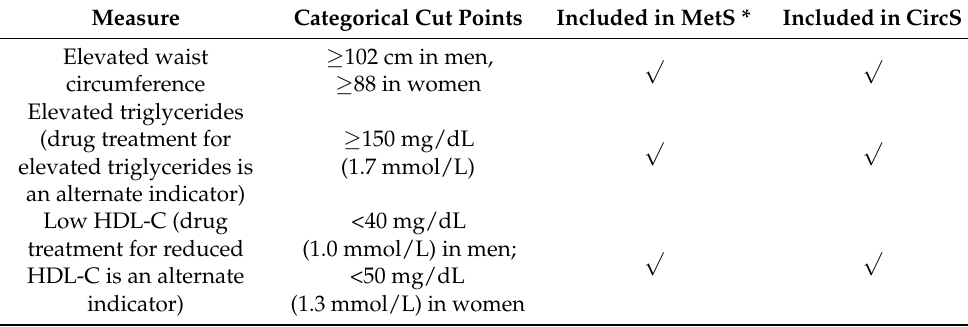
Table 1. Definition of metabolic syndrome and circadian